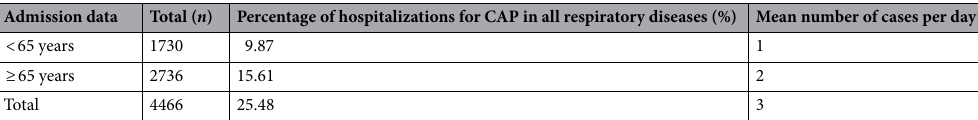
Table 1. Descriptive summary of hospital admissions of adult CAP patients. CAP community-acquired pneumonia.